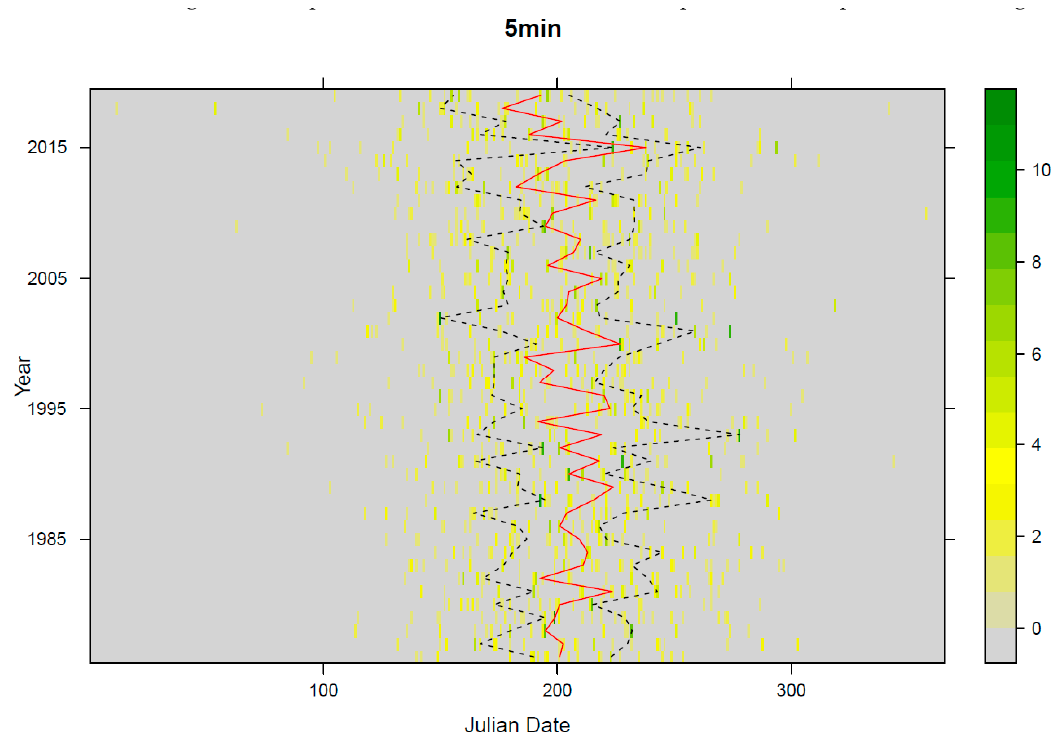
Figure 5. Clustering of the AM5 events for the 5 min rainfall duration. Red line shows the median Julian date and dotted black lines show 25% and 75% Julian date.